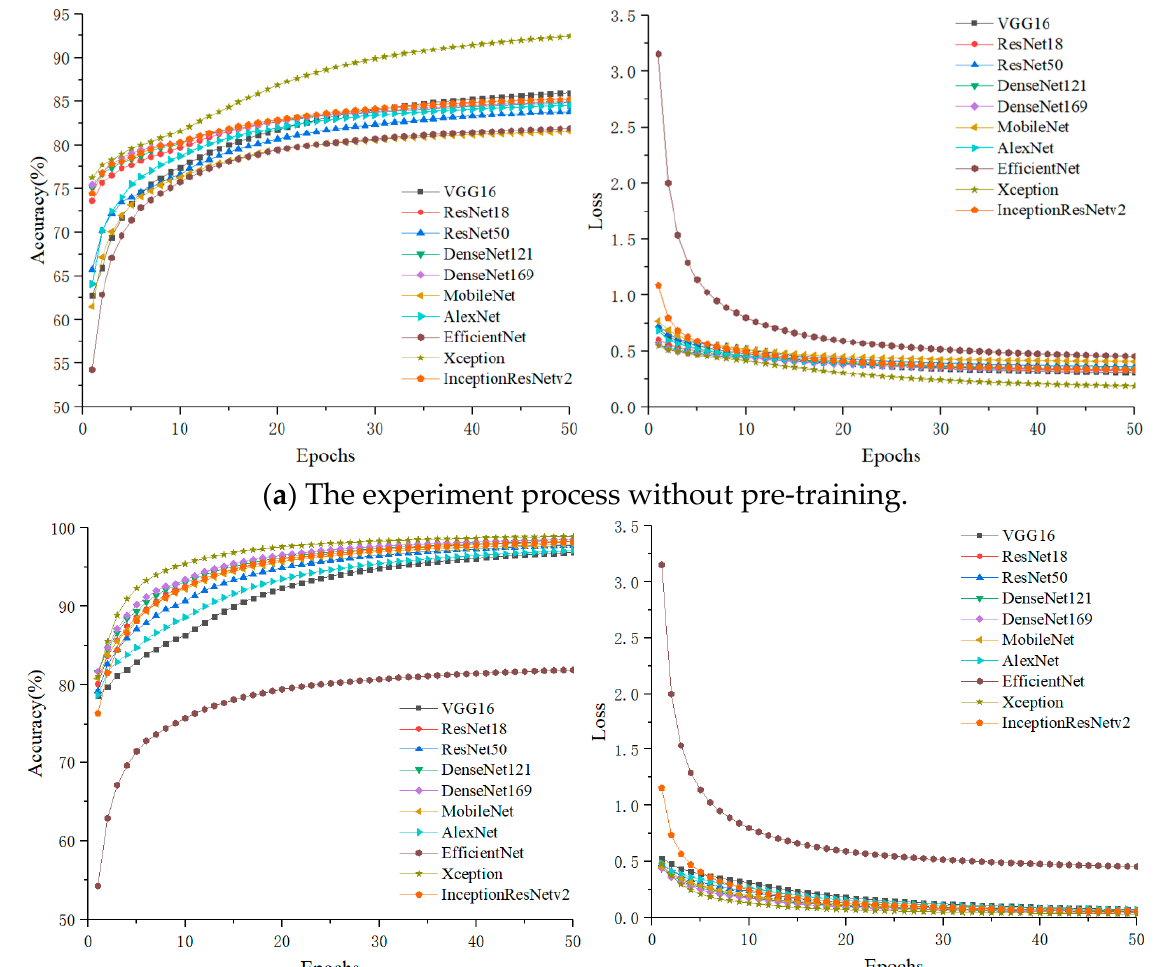
Figure 5. Comparison of training accuracy and loss in the classification control group.